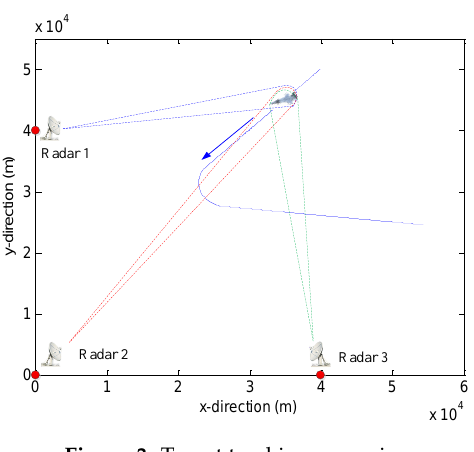
Figure 3. Target tracking scenario.